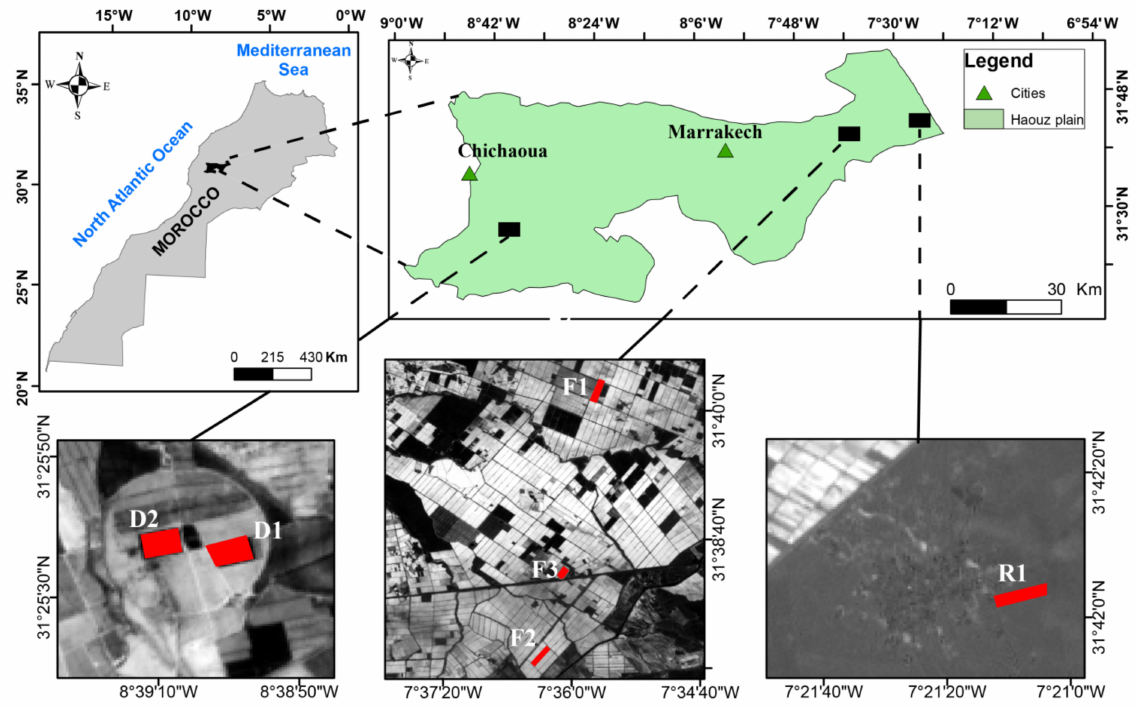
Figure 1. Location of the study area and the instrumented fields (in red), Haouz plain in the center of